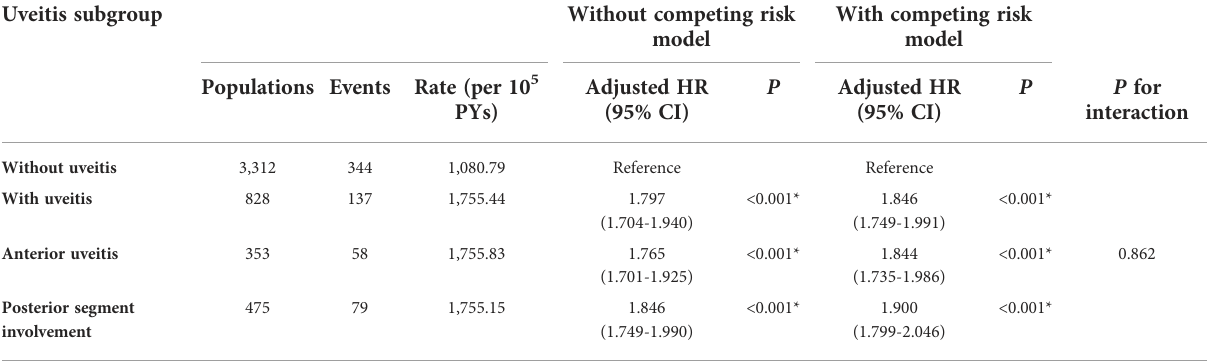
TABLE 4 Risks of stroke among different uveitis subgroups by using Cox proportional hazards model with/without Fine & Gray's competing risk model. Uveitis subgroup